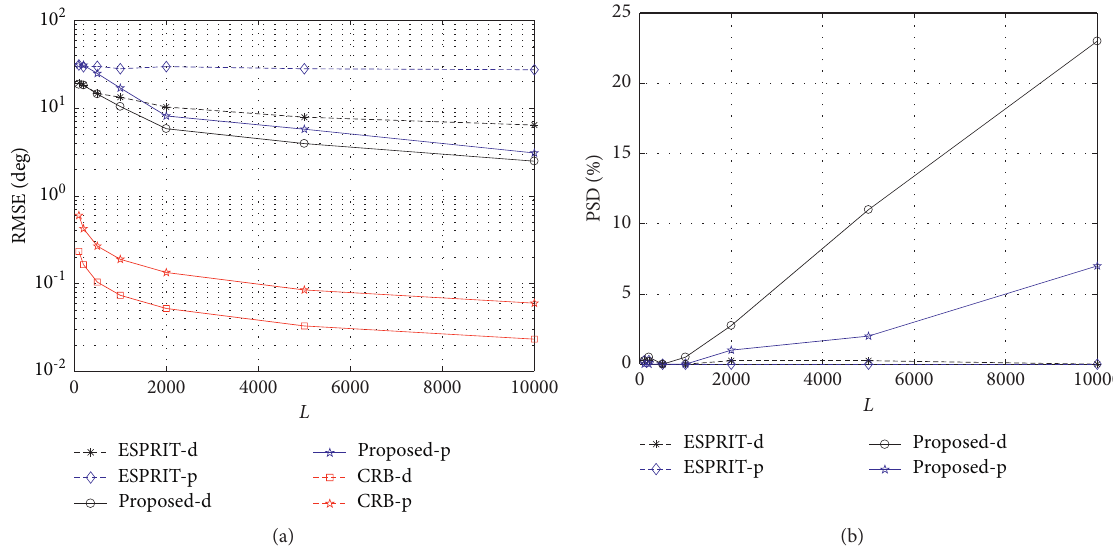
Figure 4: RMSE performance and PSD performance versus L (a) RMSE vs. L (b) PSD vs. L